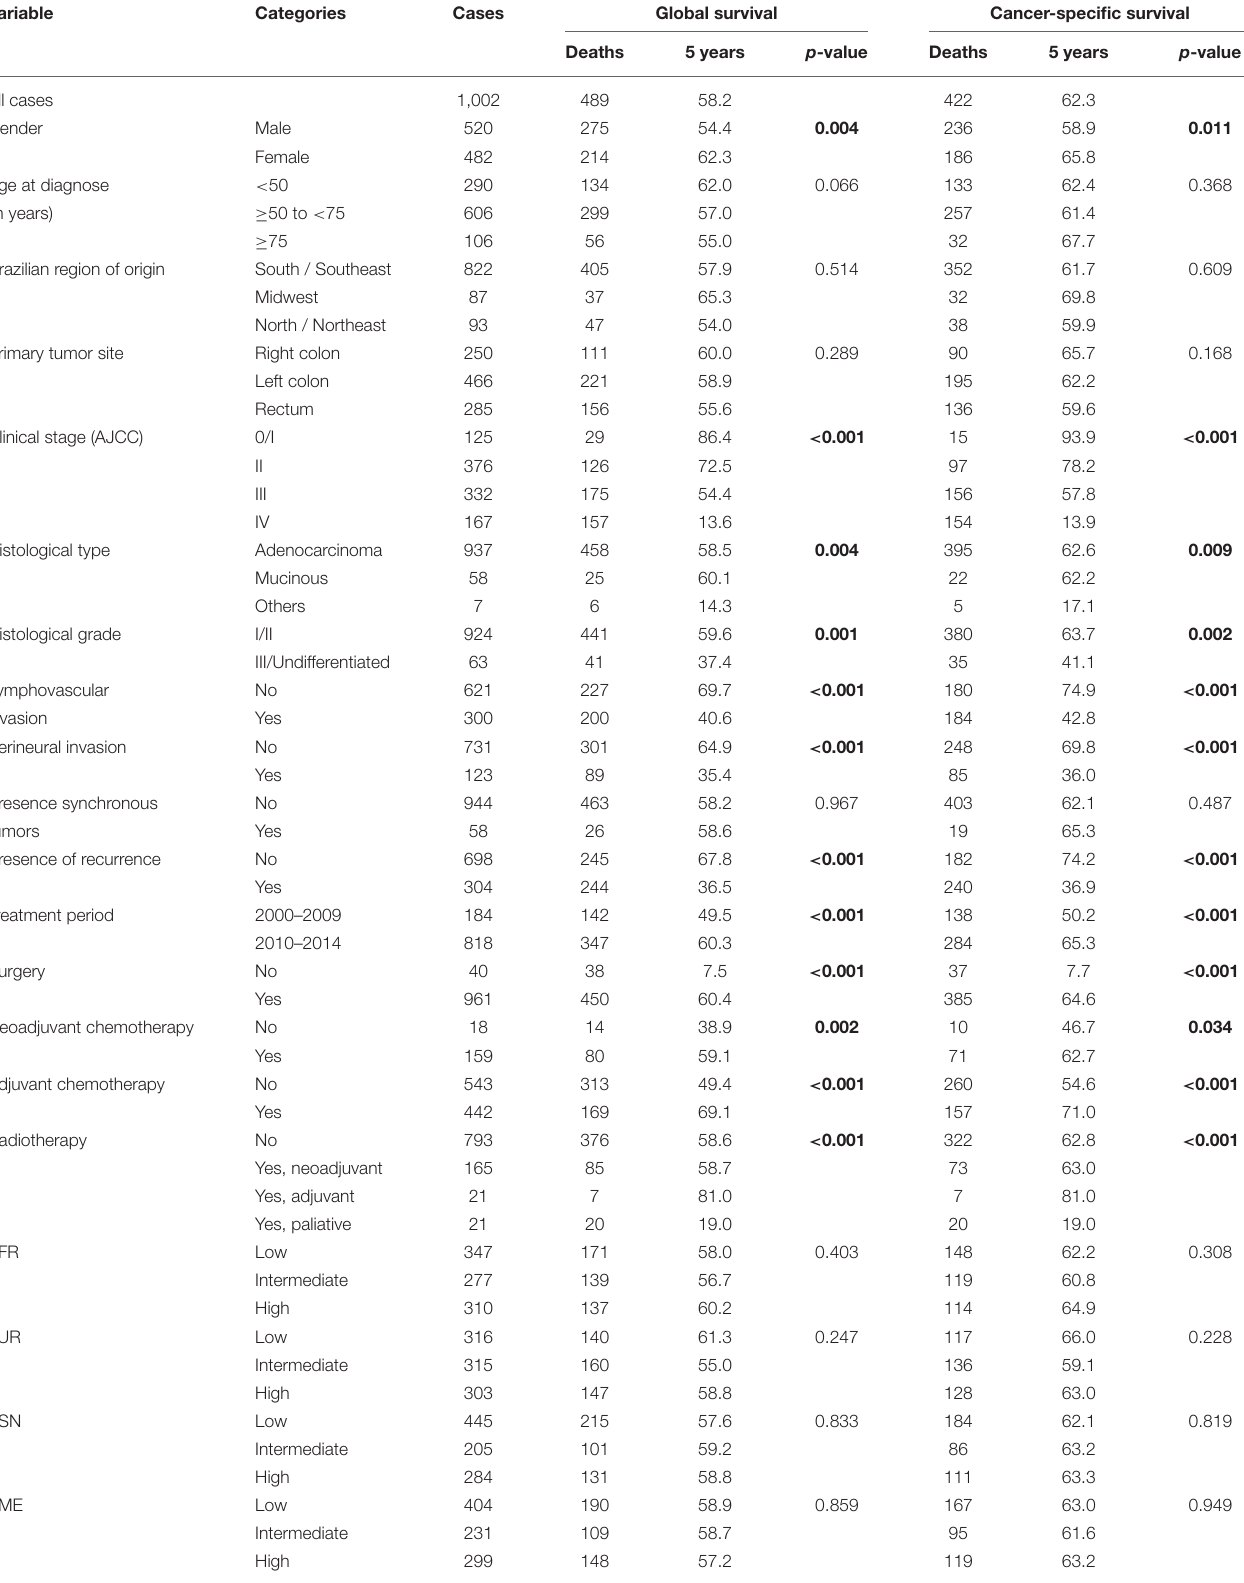
TABLE 4 | Kaplan-Meier estimates of overall survival and cancer-specific survival of colorectal cancer patients ( n = 1,002).